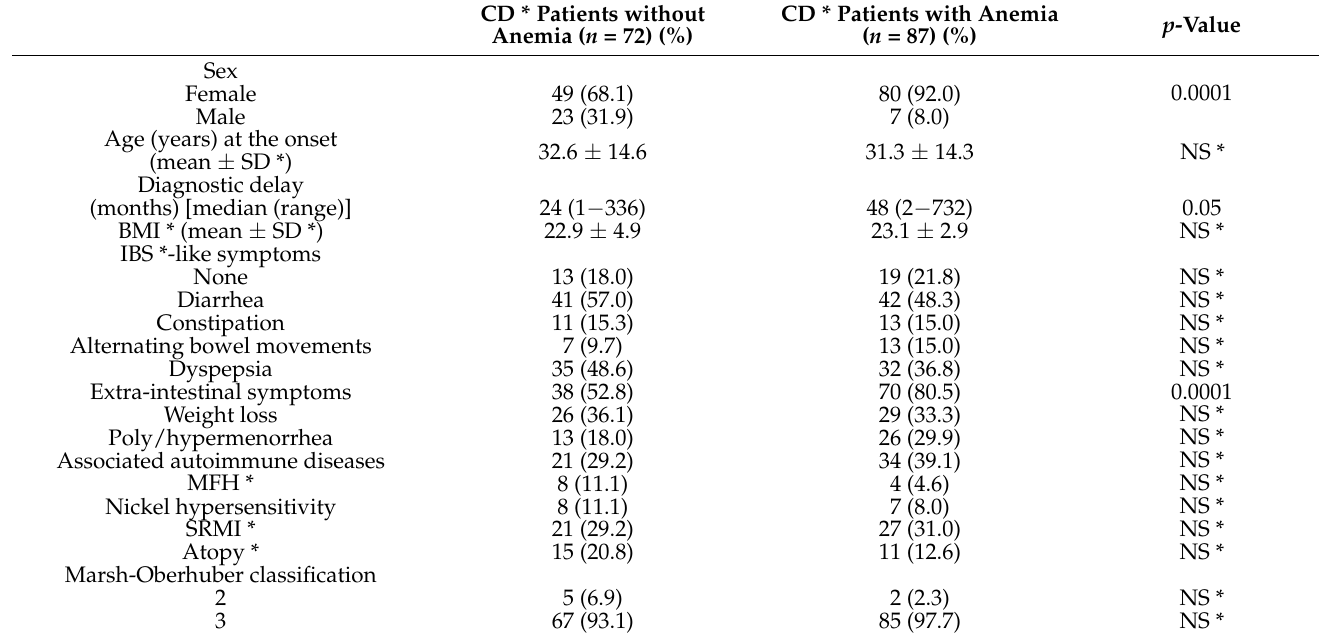
Table 1. Demographic, clinical and histological characteristics of anemic and non-anemic CD patients. CD * Patients without Anemia ( n = 72) (%)